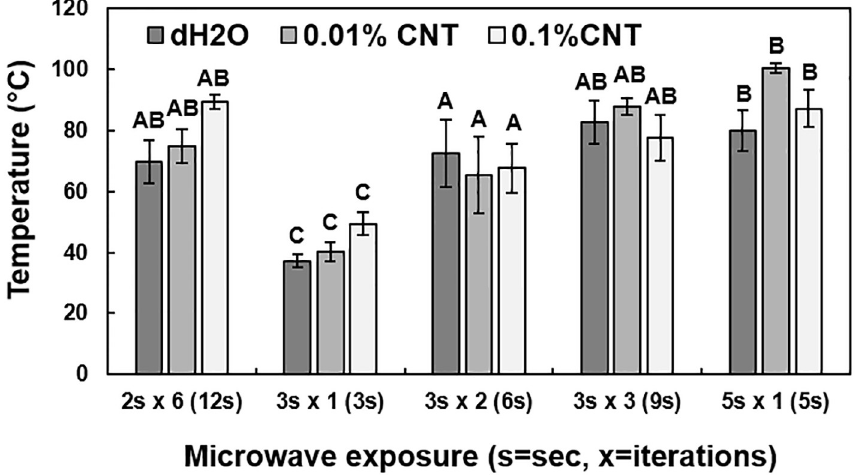
Fig 4. Temperature of scions following thermal treatments. Scions were first treated with sterile deionized water (dH 2 O), 0.01% (w/v) multi-walled CNTs (MWCNT), or 0.1% MWCNT dispersions and then exposed to different microwave irradiation treatments, including 2 sec in six iterations (12 sec total), 3 sec in one iteration, 3 sec in two iterations (6 sec total), 3 sec in three iterations (9 sec total), or 5 sec in one iteration. The five thermal treatments were tested to determine the optimum conditions for the remediation of X . fastidiosa . Each treatment was performed on six scion replicates. Different letters indicate significant differences. dH O-treated scions without microwave = 46.7% ± 12.5 (Fig 7). A chi-square analysis found 2